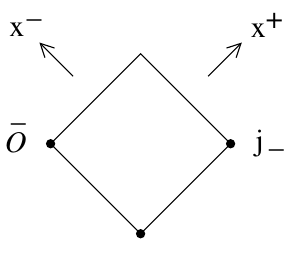
Figure 1 . O and j (cid:0) de(cid:12)ne a causal diamond on the boundary. As expected, the 3-point func- tion (2.7) has a light-cone singularity when the bulk point is null separated from O . But it also has an ill-de(cid:12)ned singularity when the bulk point is null separated from the bottom corner of the causal